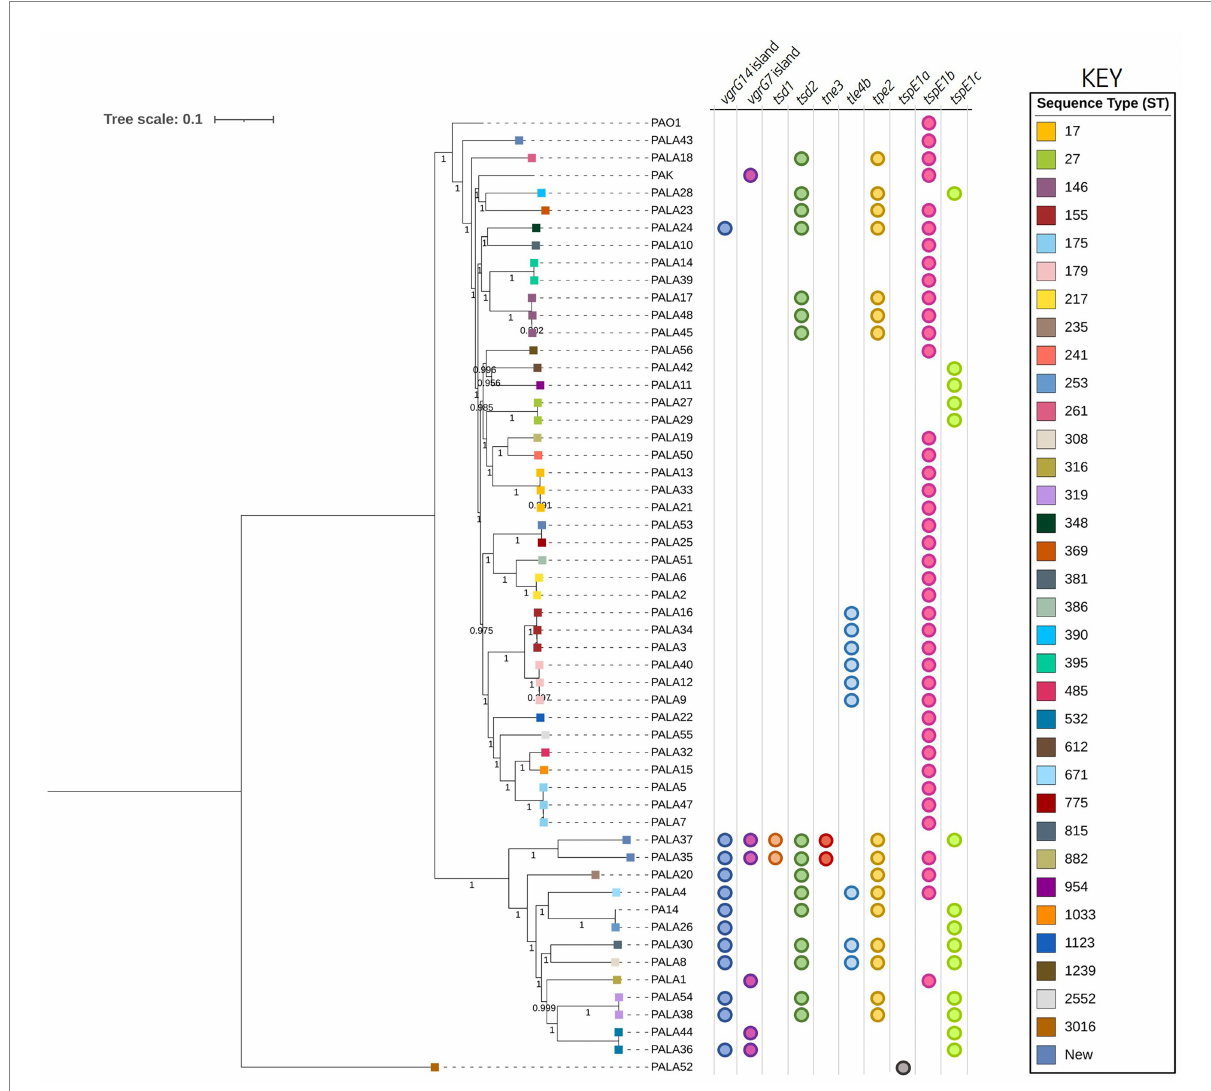
FIGURE 2 Phylogenetic tree highlighting the diversity of clinical P. aeruginosa isolates under study and distribution of effector genes in the accessory genome. The tree was constructed using the clinical isolate genomes and reference P. aeruginosa strains PAO1, PA14, and PAK. SNP analysis was inferred using CSI Phylogeny with PAO1 as a reference and visualised using iTOL. Sequence type (ST) is annotated on the isolate node with squares coloured according to the key. The scale bar indicates the genetic distance and bootstrap values are indicated. Circles indicate the presence of genes encoding putative effectors/ vgrG islands in the respective